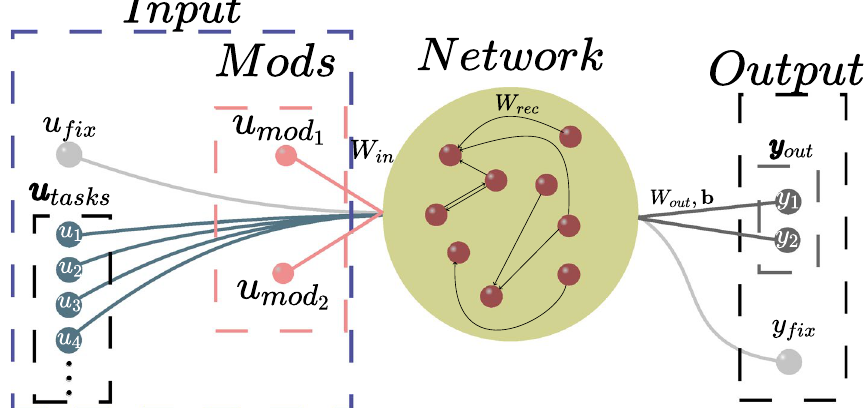
Figure 1. Architecture of the spiking neural network. The input layer sends three distinct classes of inputs—the fixation signal u fix , the sensory inputs of two modalities u mod = ( u mod 1 , u mod 2 ) , and the task coding one-hot vector u tasks —through the input matrix W in . The central element—the spiking recurrent neural network—is characterized by the connectivity matrix W rec . Its activity is output via matrix W out and vector b by the output response units y out = ( y 1 , y 2 ) and fixation y fix